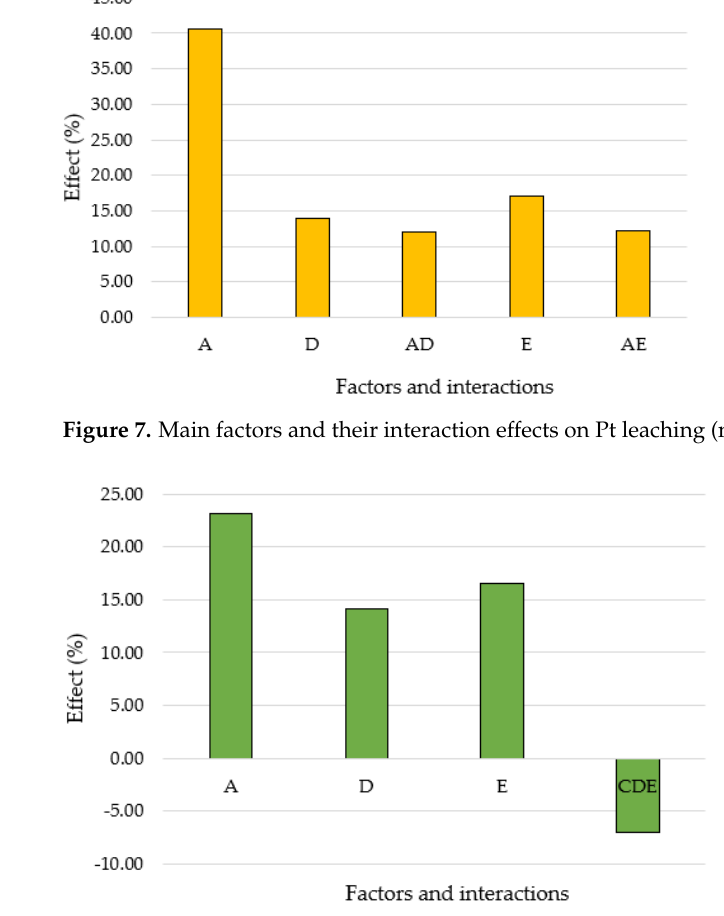
Figure 8. Main factors and their interaction effects on Pd leaching (new method).